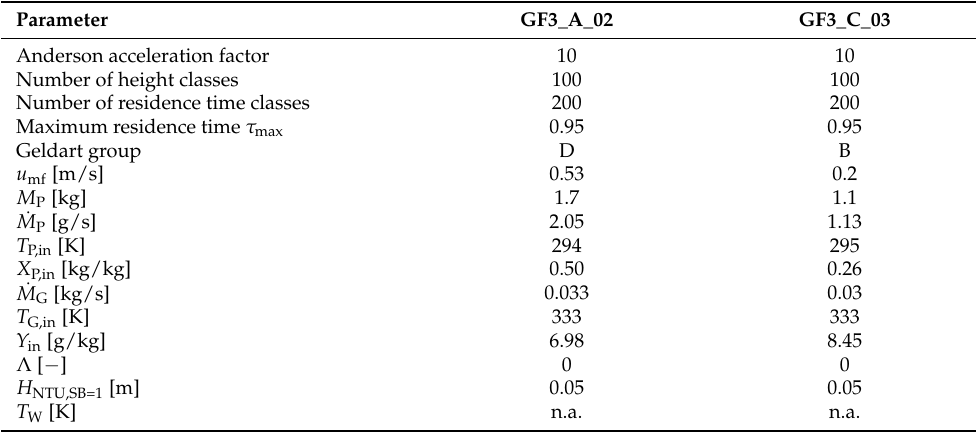
Table 3. Simulation parameters of reference cases for sensitivity